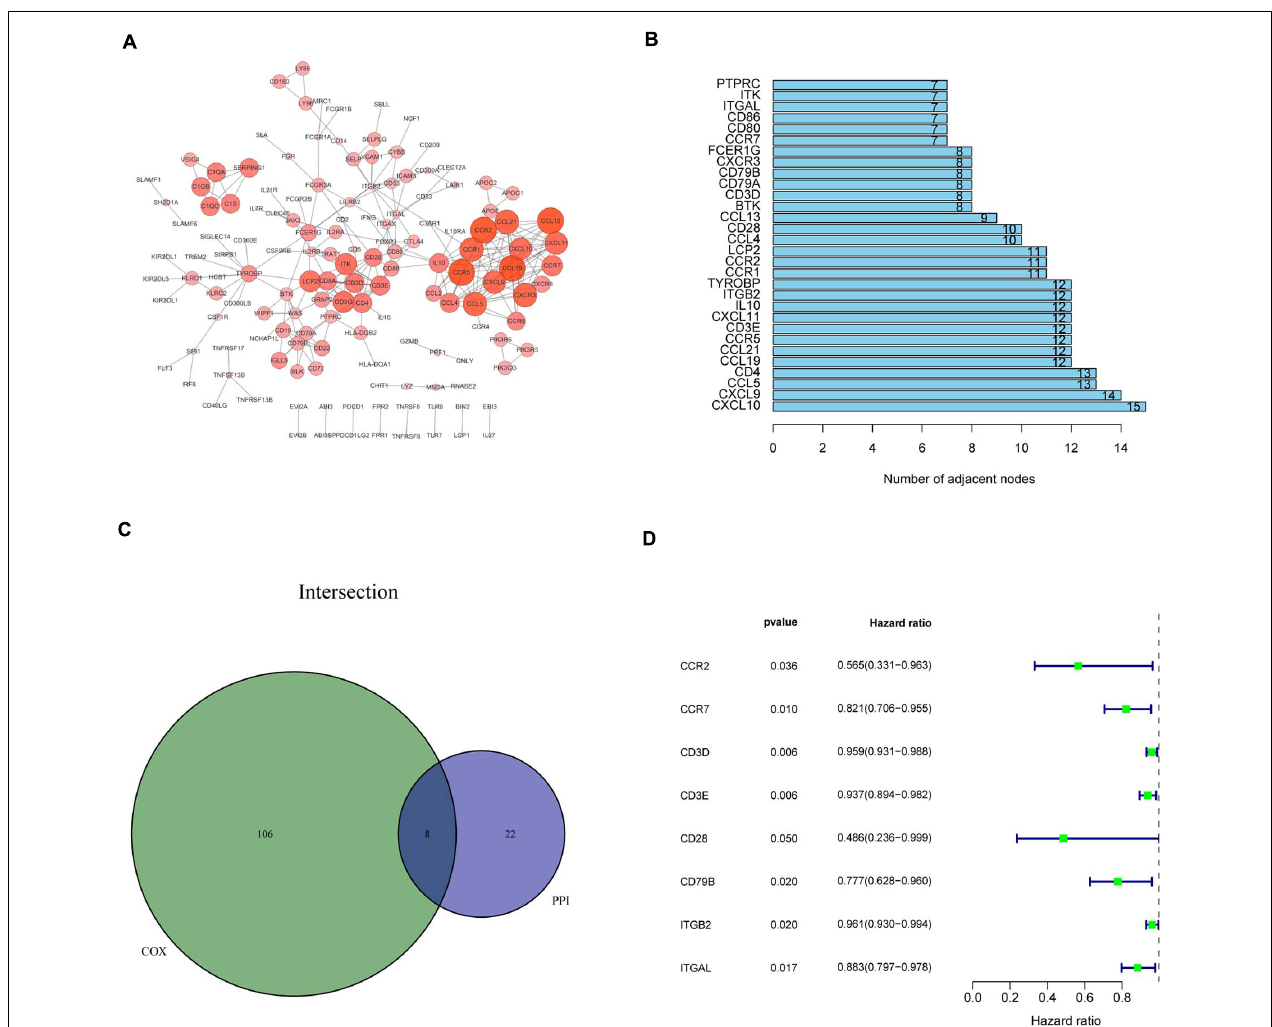
FIGURE 3 | Protein–protein interaction (PPI) network and univariate Cox regression analysis of immune-related genes (IRGs). (A) The interaction network was constructed using the nodes with interaction confidence value > 0.95. (B) The top 30 genes ordered according to the number of nodes. (C) Venn plot showing the common factors shared by the leading 30 nodes in PPI and top significant factors in univariate Cox regression analysis. (D) Univariate Cox regression analysis of the common eight IRPGs.